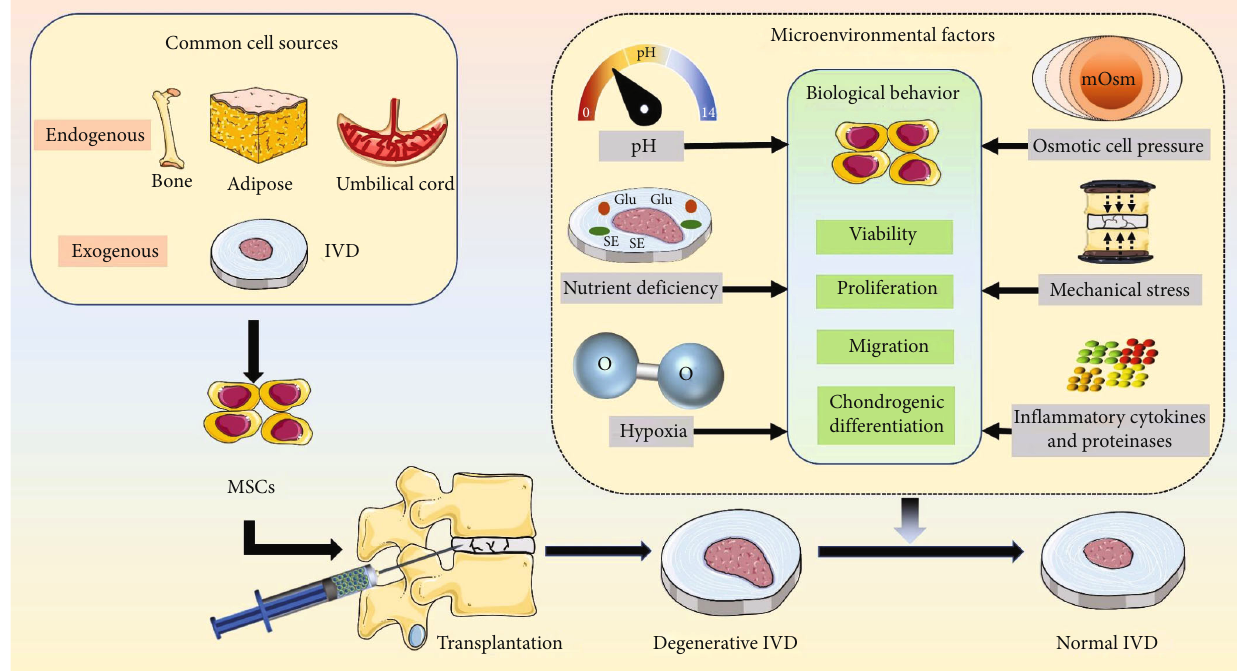
Figure 2: Schematic diagram of the in fl uence of six intervertebral disc microenvironmental factors on the biological behavior of the implanted mesenchymal stem